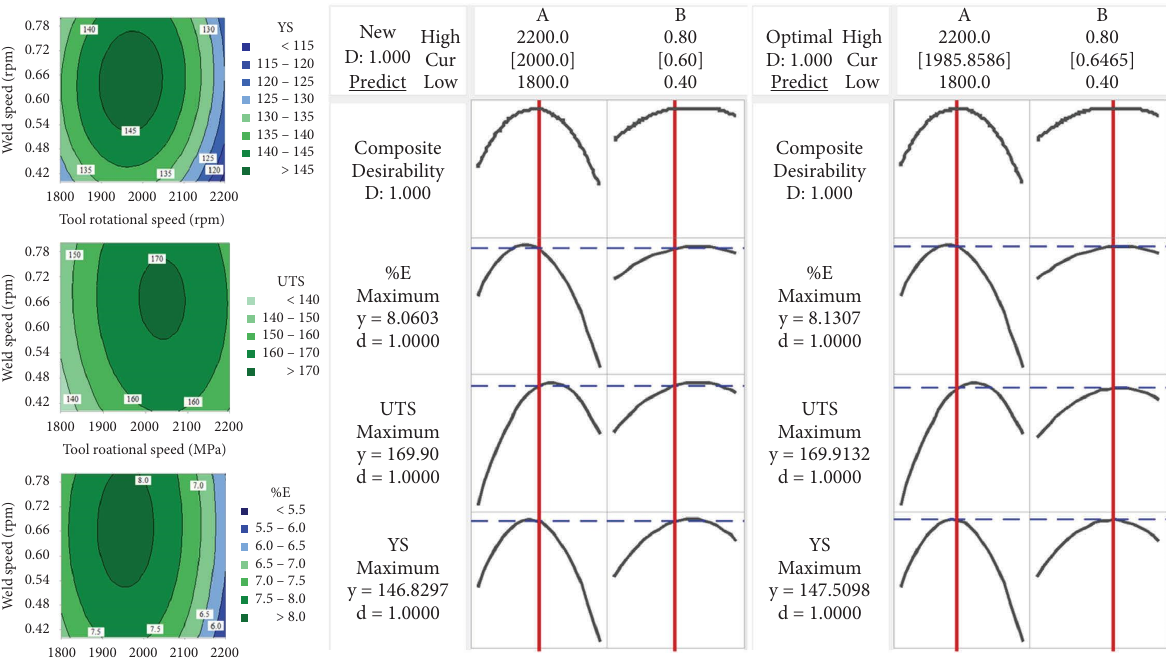
Figure 10: Optimized process parameters for high values of yield strength (YS), ultimate tensile strength (UTS), and percentage of elongation (%E) during the FSW of AA pipes [46].